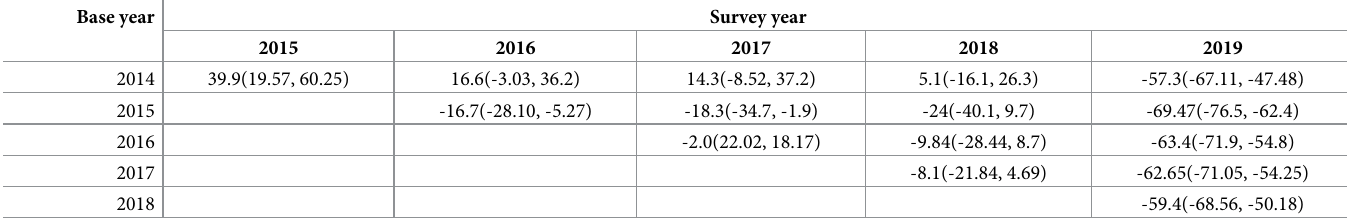
Table 3. Percentage change in receipt of high-quality family planning services across survey